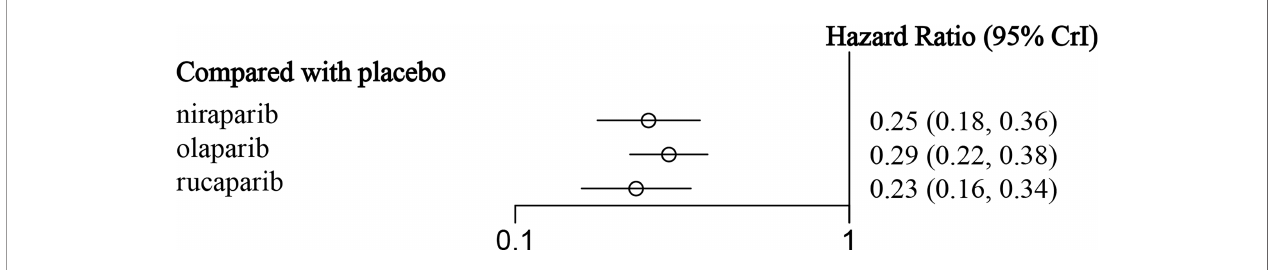
FIGURE 6 | The forest plot of PFS in BRCA-mutated patients.